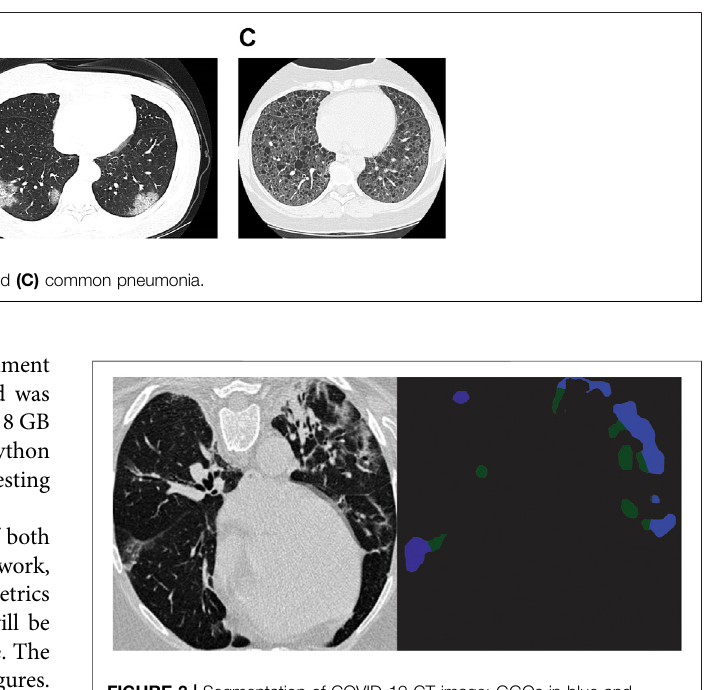
FIGURE 3 | Segmentation of COVID-19 CT image; GGOs in blue and consolidation in green.